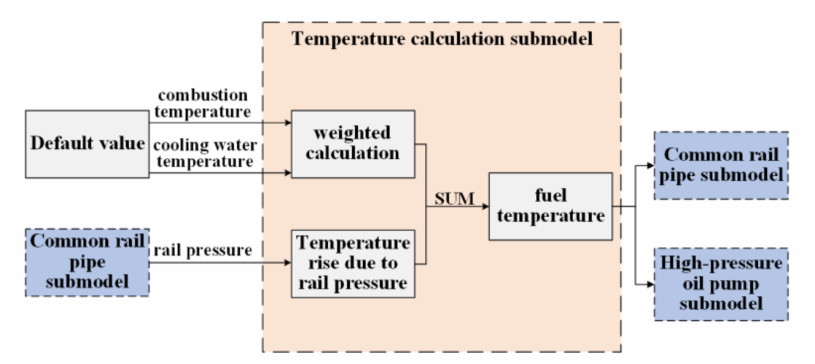
Figure 14. Development process of the temperature calculation